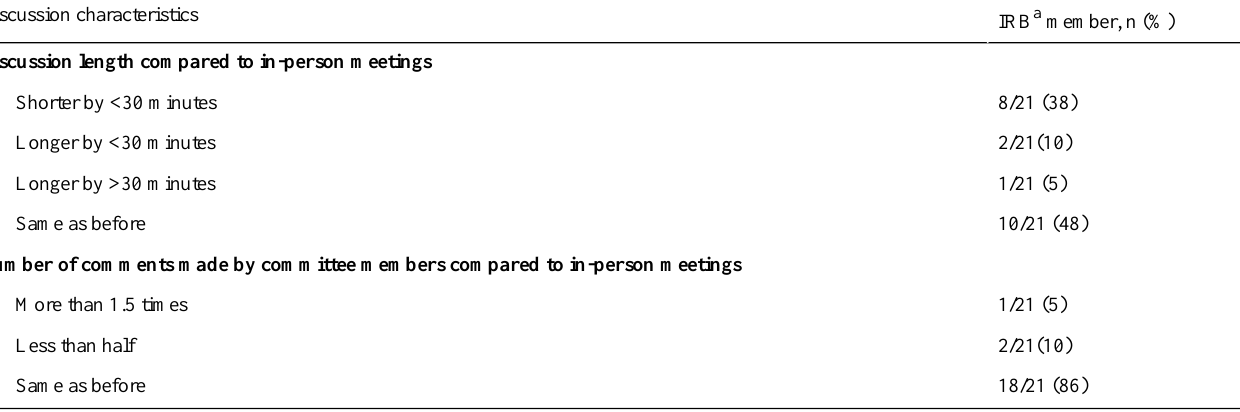
Table 4. Comparison of the discussion characteristics of institutional review board meetings conducted through web conference systems during the COVID-19 epidemic and those of in-person meetings conducted before the COVID-19